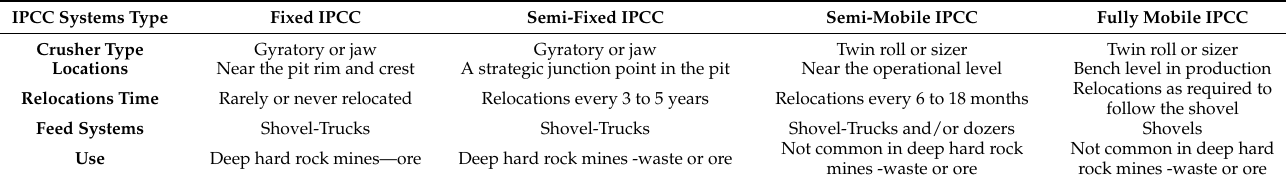
Table 1. IPCC systems’